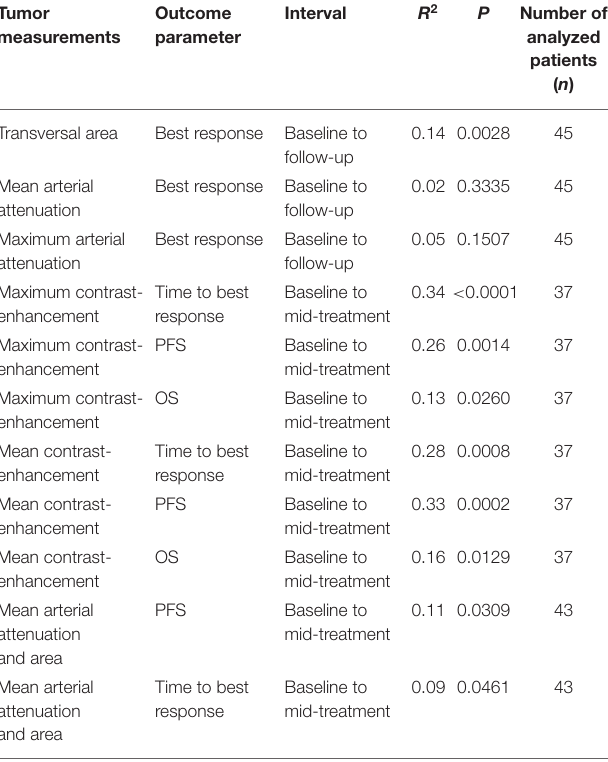
TABLE 2 | Correlations between input data and outcome parameters.